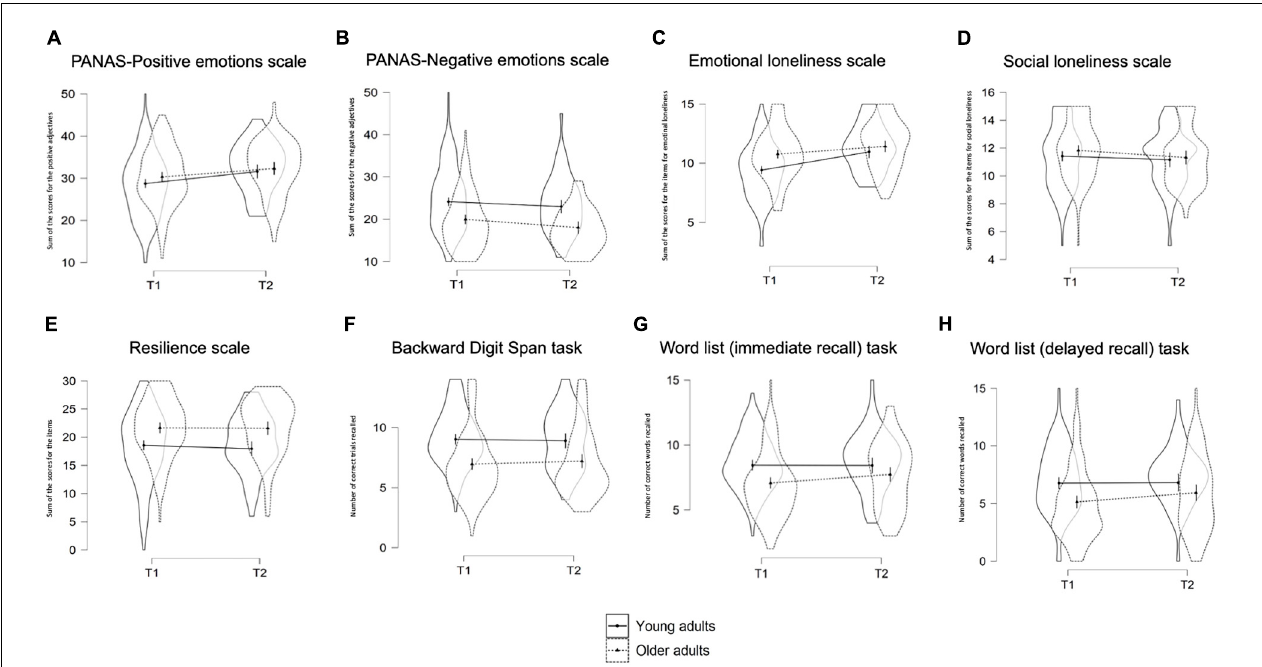
FIGURE 1 | Models plots by age group (young adults vs. older adults) and time (T1-May 2020 vs. T2-September 2020) for each measure of interest. PANAS positive emotions scale (A) ; PANAS negative emotions scale (B) ; Emotional loneliness scale (C) ; Social loneliness scale (D) ; Resilience scale (E) ; Backward Digit Span Task (F) ; Word list immediate recall (G) ; Word list delayed recall (H) . Plots of the models with mood, BCS, and CCS as covariates. For the Social and Emotional Loneliness scales lower scores correspond to higher perceived social and emotional loneliness,